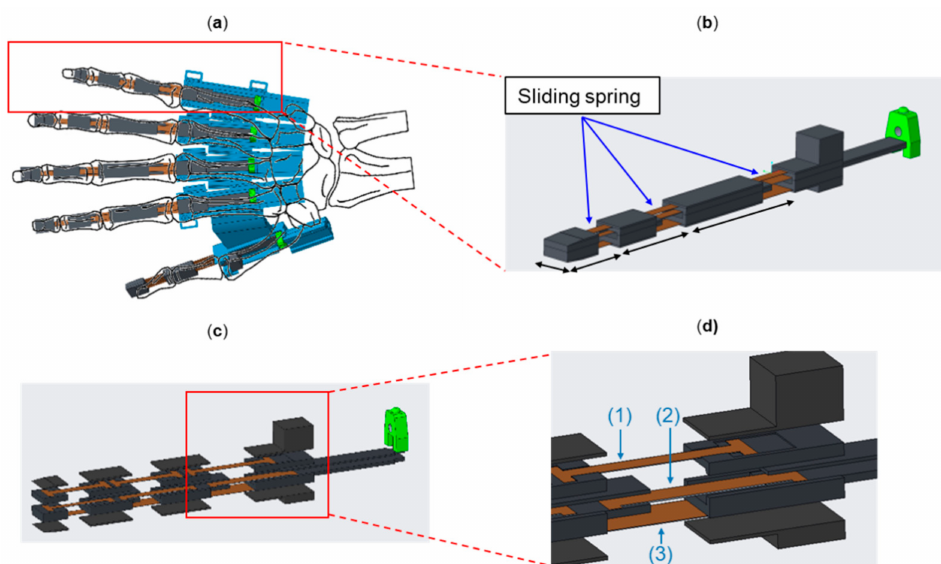
Figure 2. Hand exoskeleton ( a ) overview of the hand exoskeleton, ( b ) single-finger skeleton, ( c ) ex- ploded view of the sliding spring, and ( d ) passive, active, and fixed sliding springs which are indicated by (1), (2), and (3),